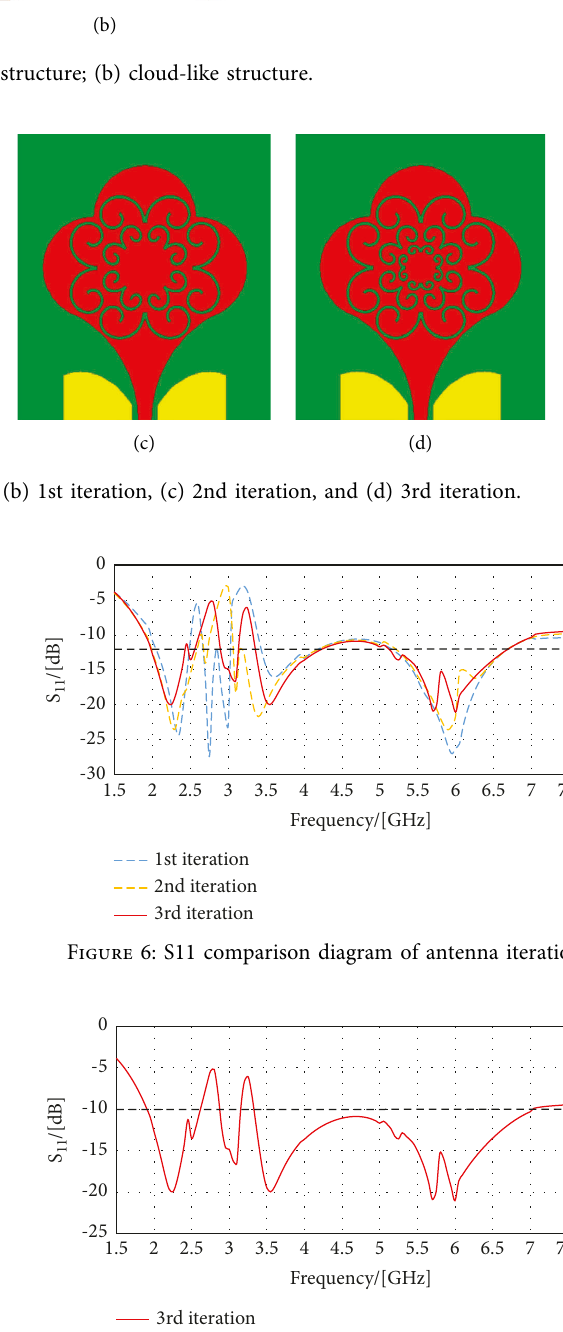
Figure 7: The S11simulation value of the final antenna